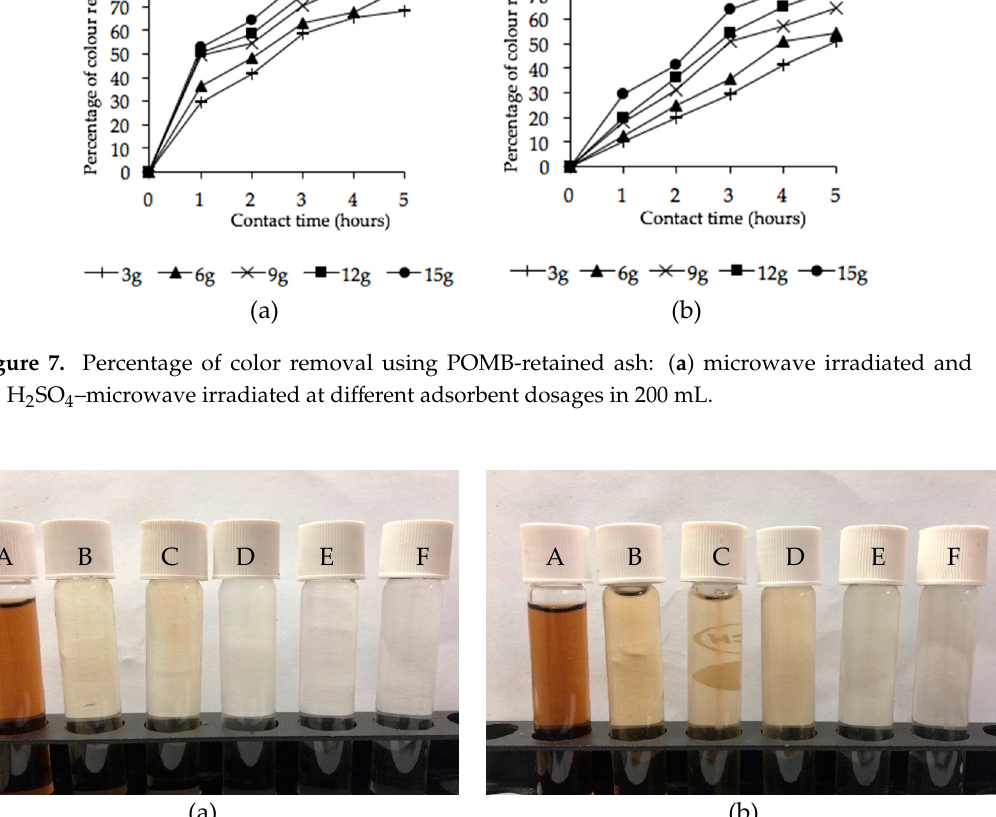
Figure 7. Percentage of color removal using POMB-retained ash: ( a ) microwave irradiated and ( b ) H 2 SO 4 – microwave irradiated at different adsorbent dosages in 200 mL.